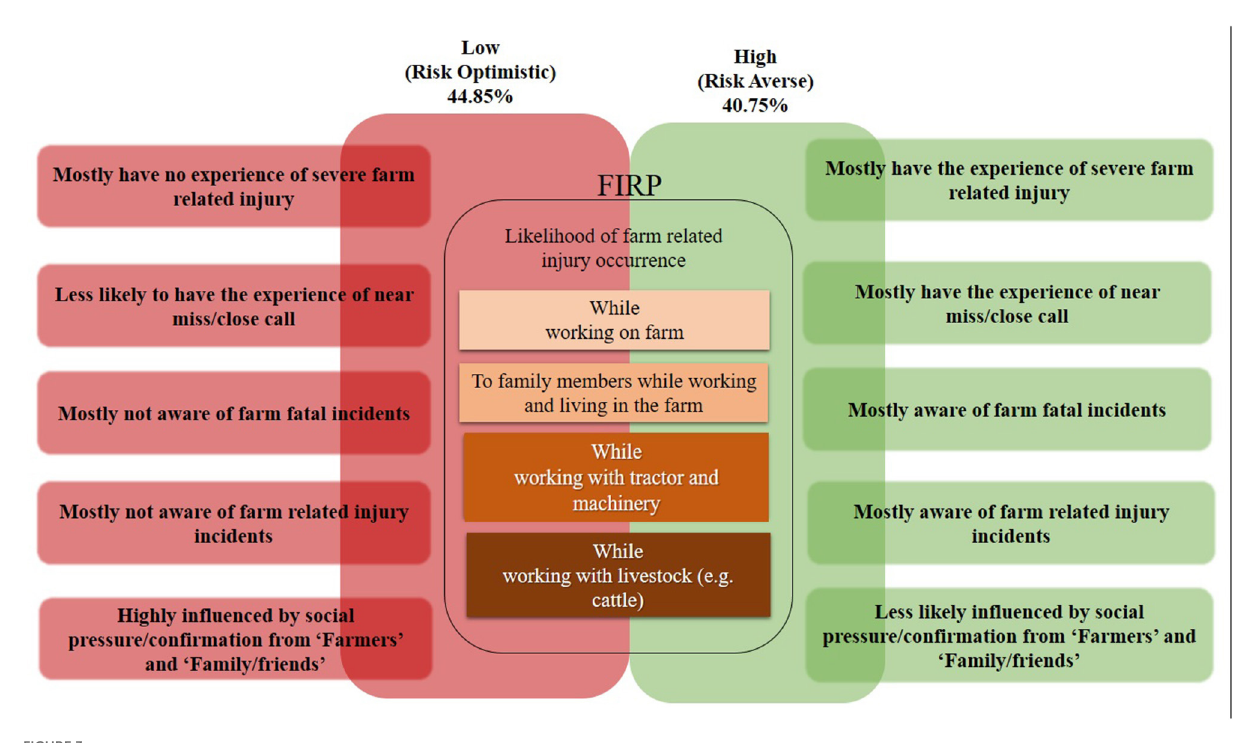
FIGURE3 The role of experience, awareness, and social influences on